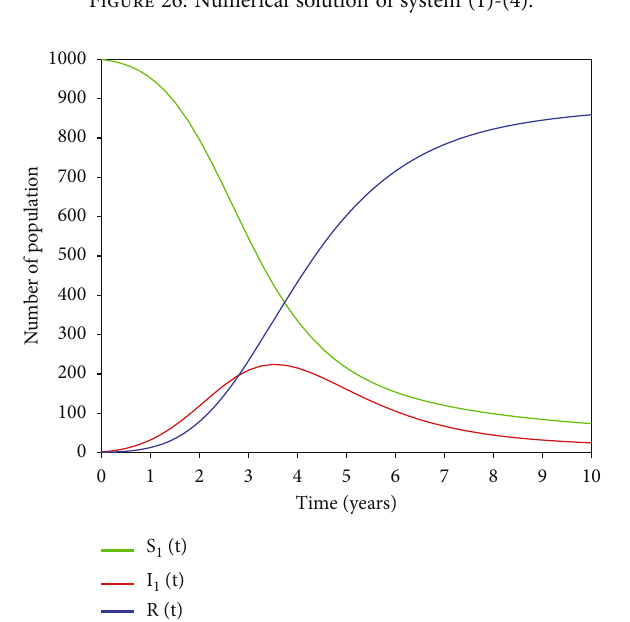
Figure 26: Numerical solution of system (1)-(4).